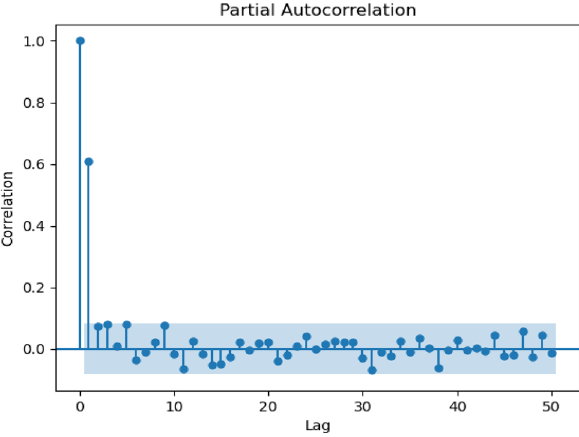
Figure 6. Partial autocorrelation for the weekly scenario.